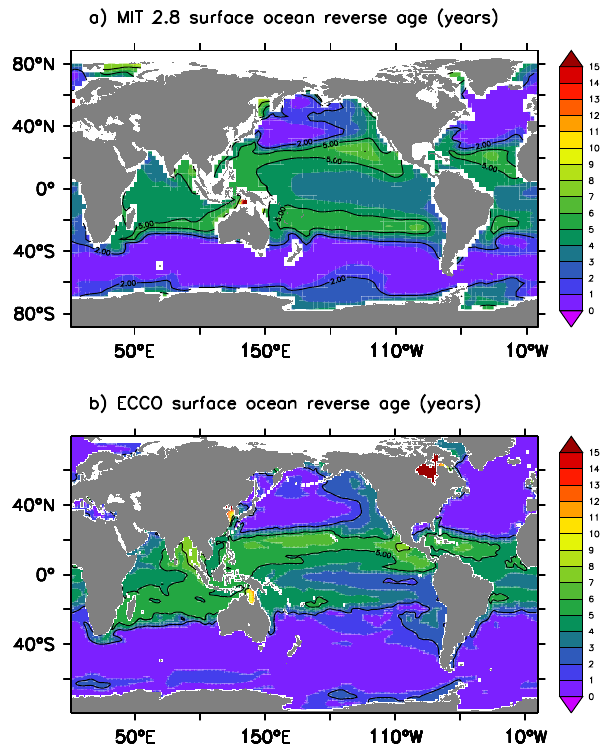
Figure 6. Age relative to depth (yr) computed for the MIT2.8 (a) and ECCO (b) model (see text for